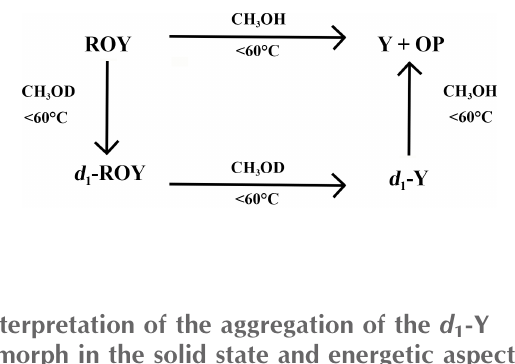
Figure 2 Crystallization of ROY yields concomitant polymorphs (top); crystal- lization of d 1 -ROY under the same conditions gives the Y polymorph.